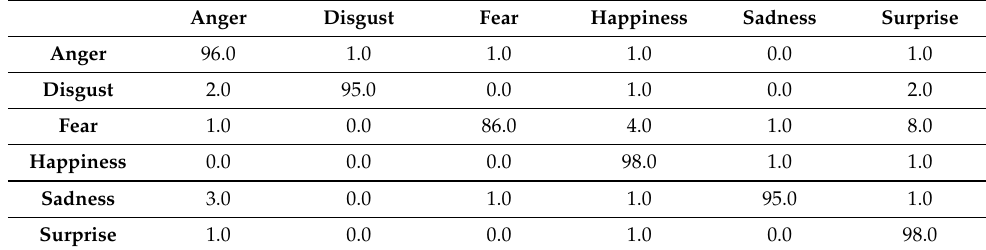
Figure 9. An example sequence of BU4D facial expression database: ( a ) texture images of surprise expression, ( b ) landmark points. Table 11. Confusion matrix for BU4D database: Weighted summation of modified CNN-based and SVM-based